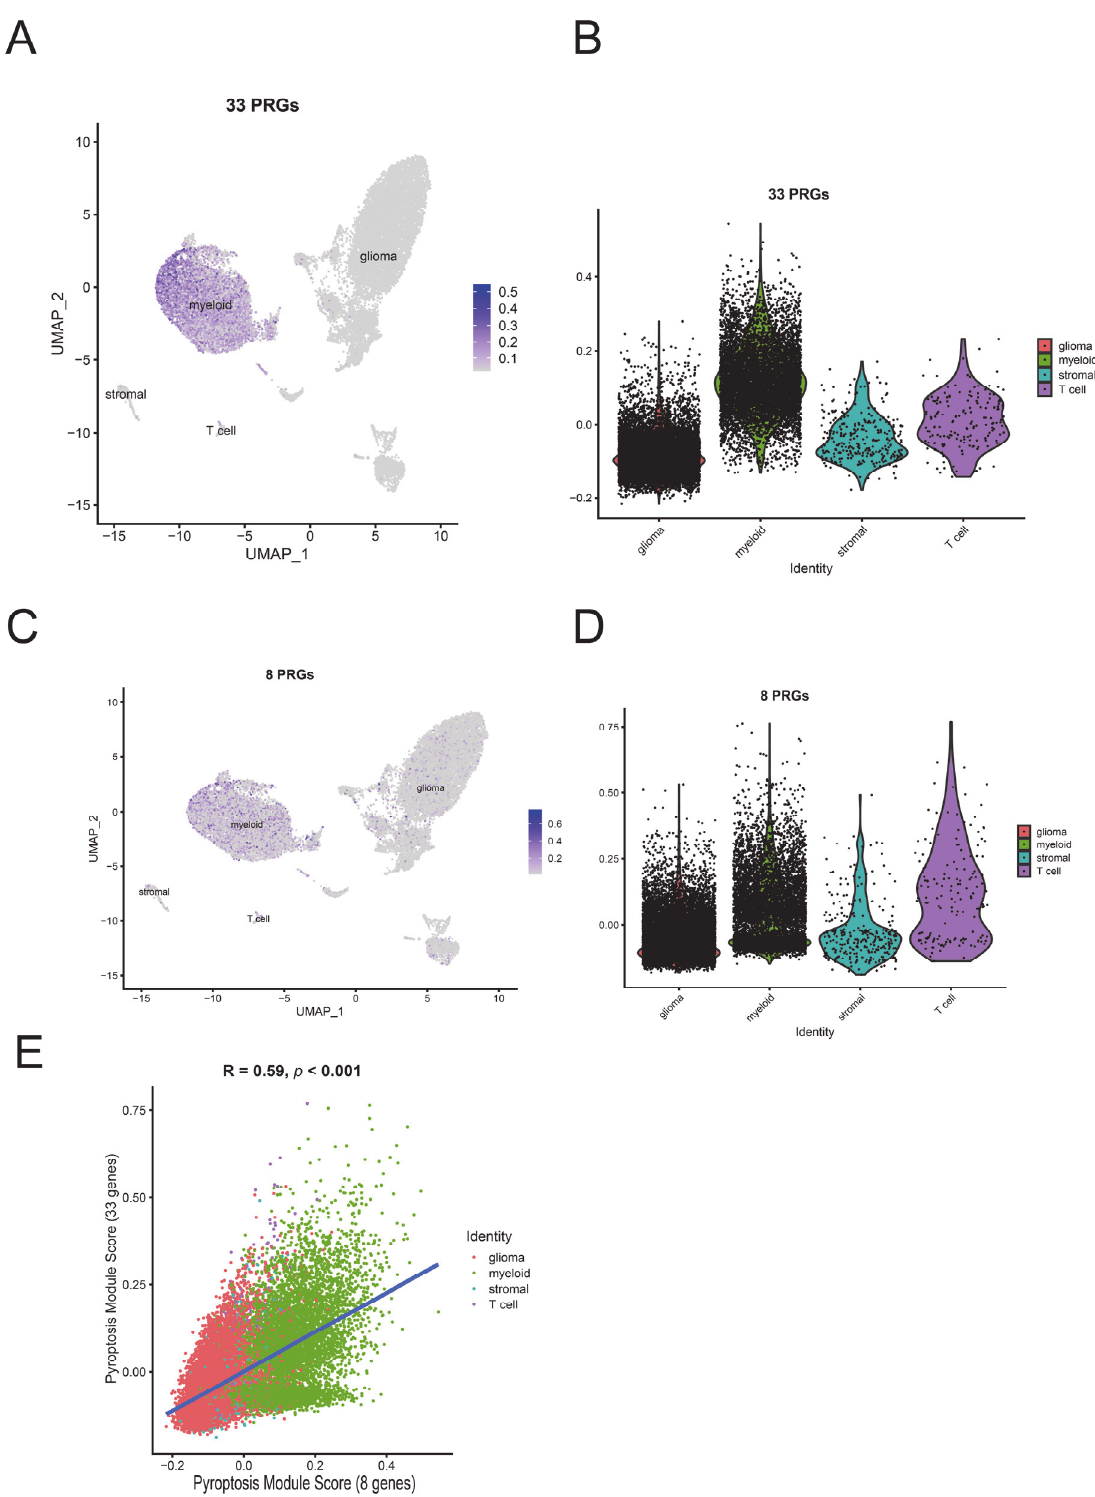
Figure 8. Single-cell analysis of PyroScore and model genes (GSE163108). ( A ) UMAP plot for 33 PRGs: The 33 target genes were used as a gene module to calculate the score using AddModuleScore. ( B ) Violin plots of the expression of the 33 gene module. ( C ) UMAP plot for eight PRGs: The eight target genes were used as a gene module to calculate the score using AddModuleScore. ( D ) Violin plots of the expression of the eight gene module. ( E ) Correlation between 33 PRGs modules and eight PRGs